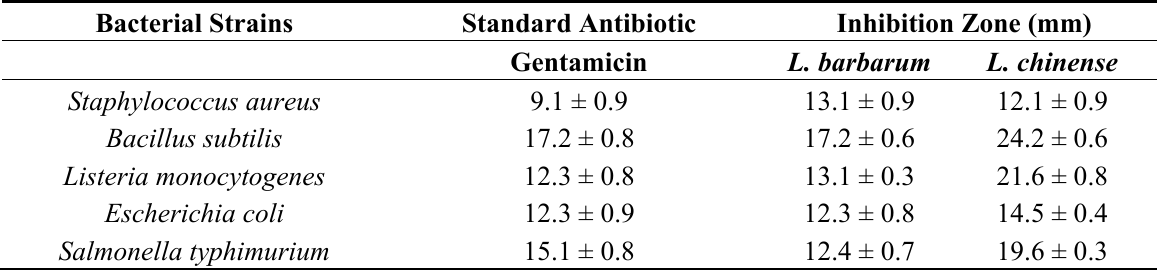
Table 4. Antibacterial activity of L. barbarum and L. chinense extracts and antibiotic against bacterial species tested by disc diffusion assay.